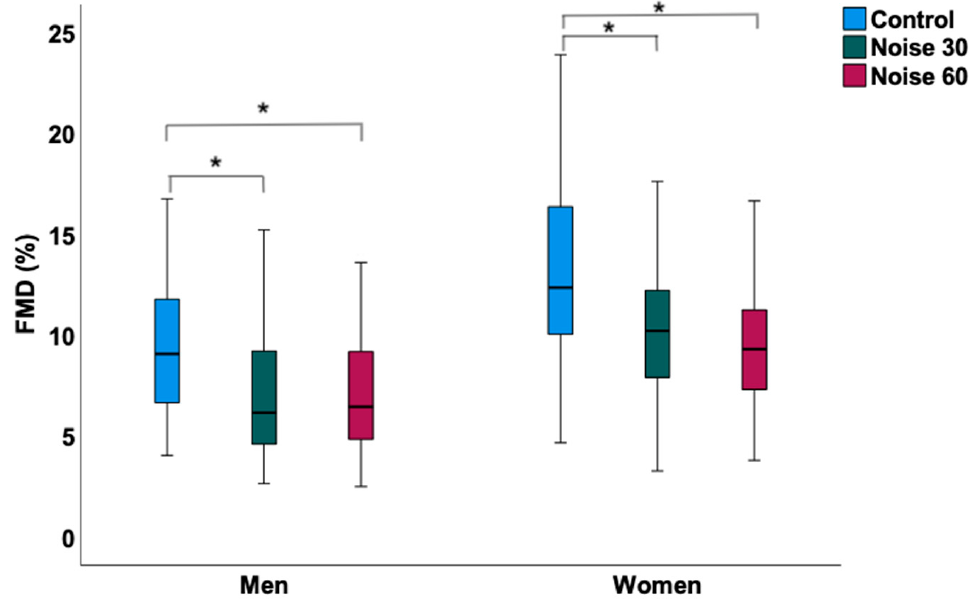
Figure 2. Flow-mediated dilation (FMD) upon nocturnal train noise exposure in men ( n = 35) and women ( n = 35). Exposure to both train noise patterns impaired endothelial function, although no difference was observed between Noise 30 and Noise 60 study nights. * denotes p < 0.001. Box plots indicate minimum, maximum, 25th percentile, median, and 75th percentile.